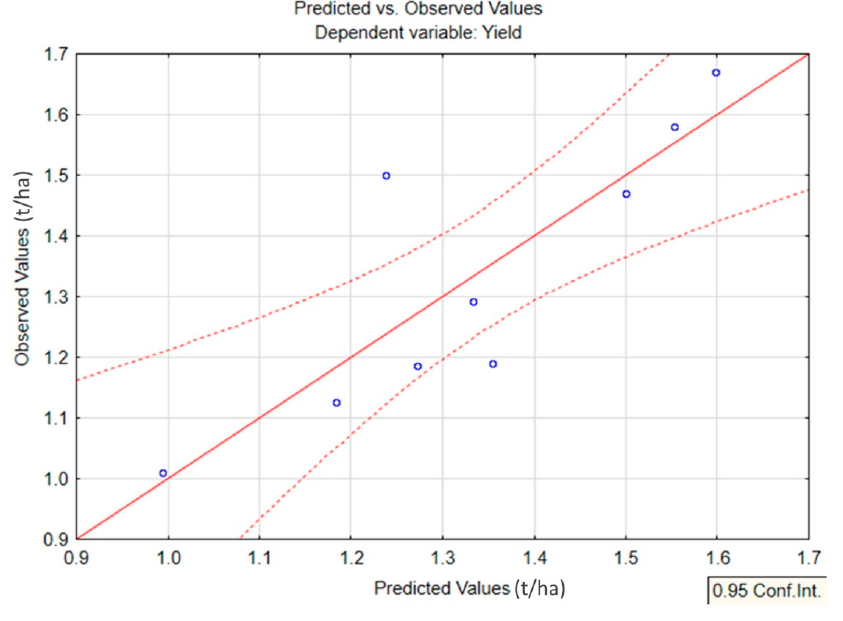
Figure 9. Actual and model estimations of soybean yield in the Khabarovsk District, 2010–2018.